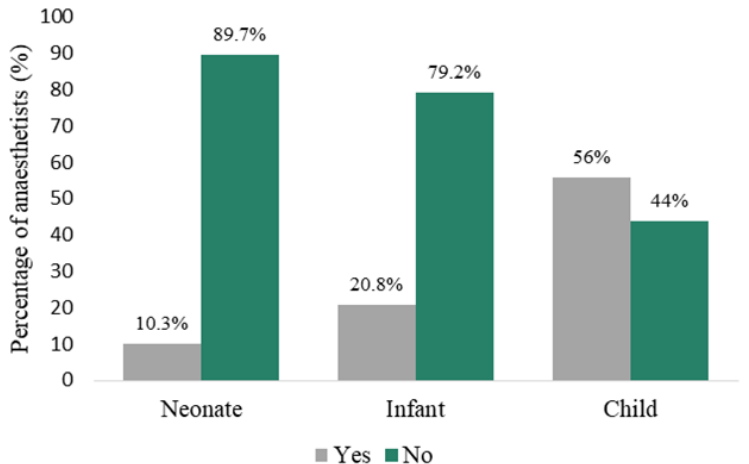
Figure 4. Use of cricoid pressure during RSI.